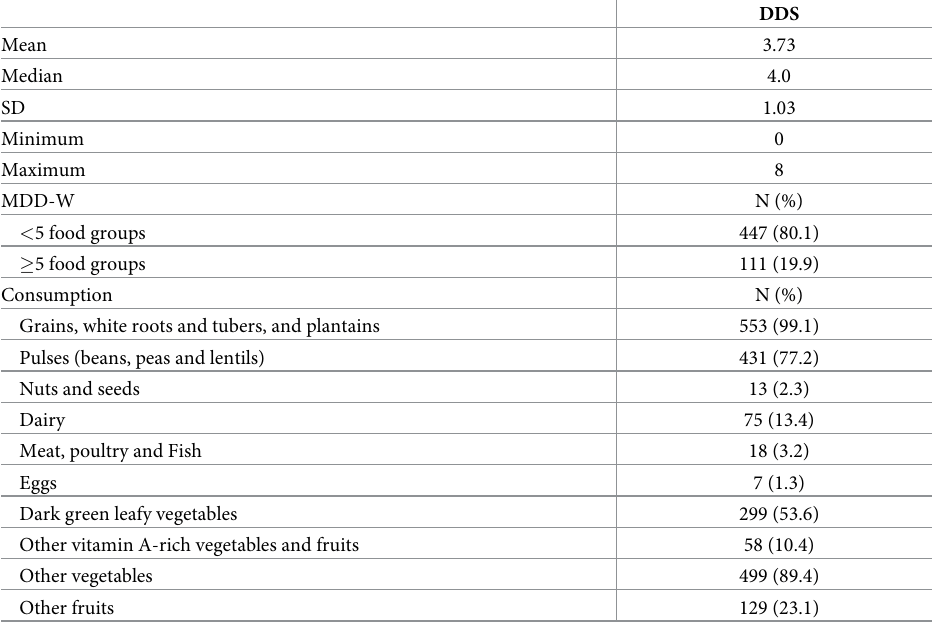
Table 3. Dietary diversity score and percentage of women consuming each of the 10 food